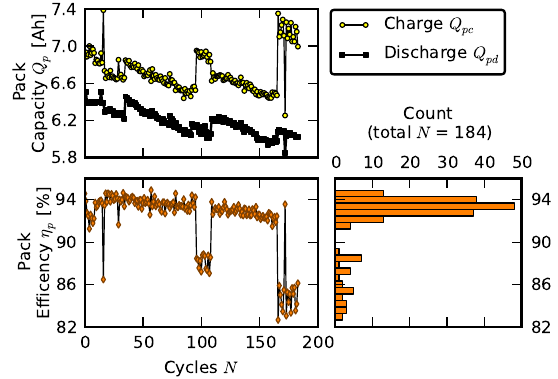
Figure 11. Coulombic efficiency of a pack during cycling (new cells).